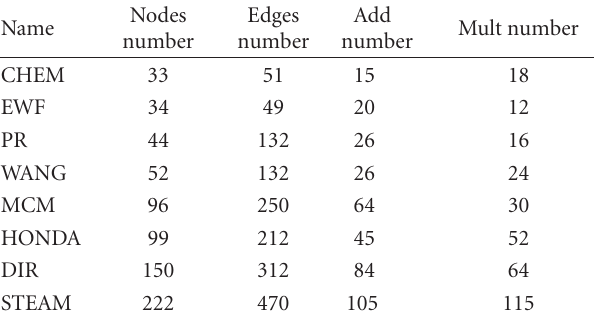
Figure 12: The delay and power tradeo ff with increasing V th for bkung with doubled device sizing (2W1L). Table 1: The profile of test benchmarks.